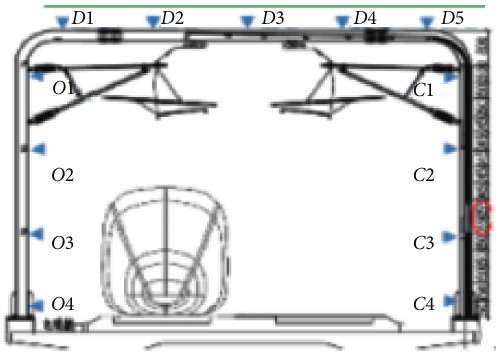
Figure 15: Layout of the monitoring points for parameter the bottom of the closed side of the SESB, which is 0.137 at C 4 and decreases rapidly in the closed side from C 3 to 0.071 at C 1. At the top of the SESB, the pressure coefficient is only 1/3 compared to that of C 4 on the bottom of the closed side and decreases linearly from 0.062 at D 5 to 0.041 at D 3. The C of the negative peak of head pulse, and positive and P negative peaks of tail pulse are in the similar cases.